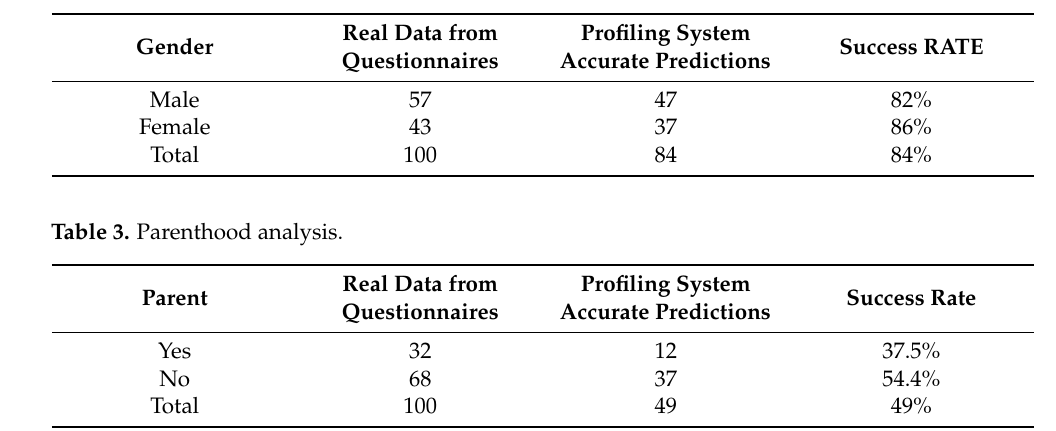
Table 2. Gender analysis.